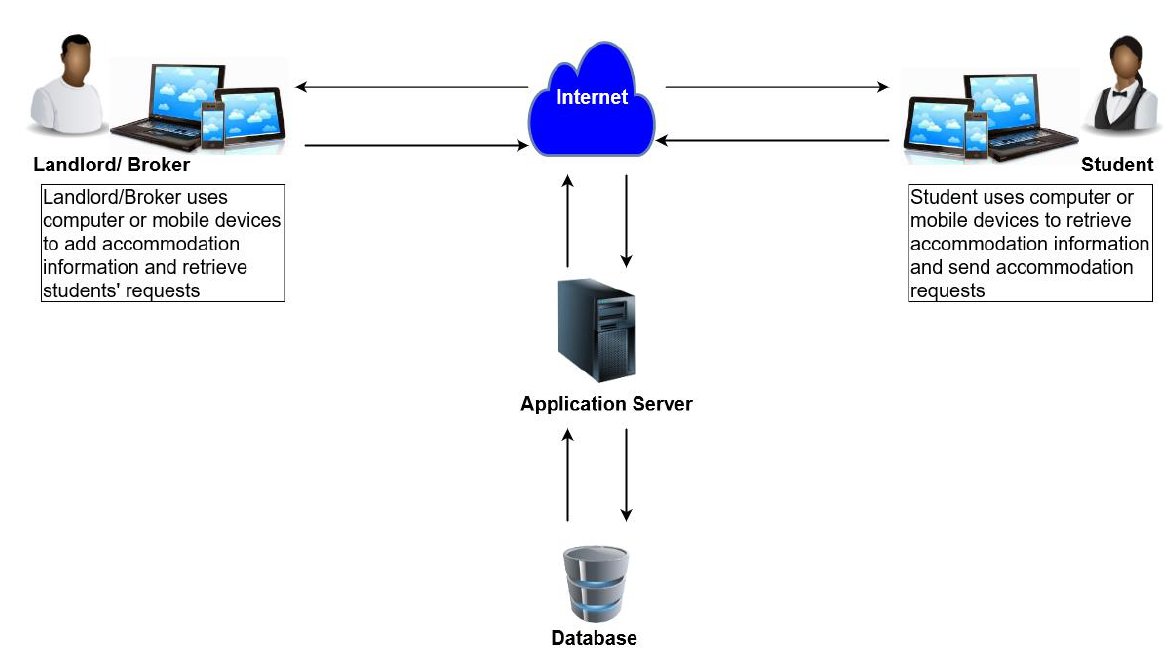
Figure 9. Conceptual Framework for The Proposed